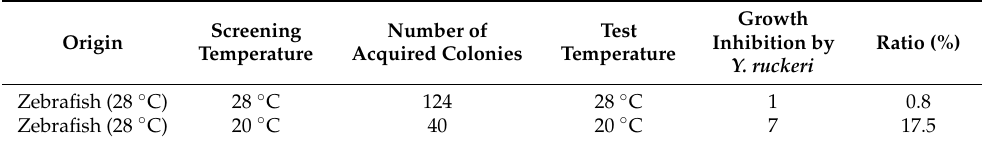
Table 1. Growth inhibition of fish skin bacteria by Y. ruckeri.